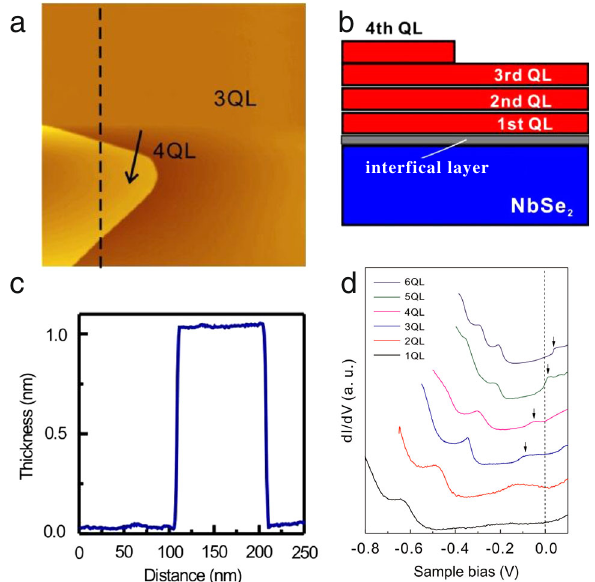
Fig. 1 a An STM image of Bi 2 Te 3 / NbSe 2 . b Sketch of the heterostructure. c Line pro fi le of Bi 2 Te 3 / NbSe 2 at position indicated by the black dashed line in ( a ). d The dependence of Fermi level on the thickness of Bi 2 Te 3 (reprinted with permission from ref. 16, copyright 2015 by the American Physical